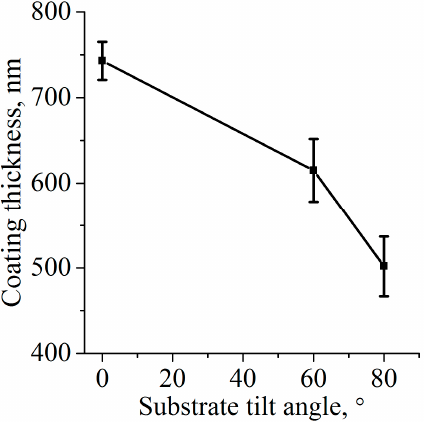
Figure 2. Plot of the coating thickness against the substrate tilt angle.